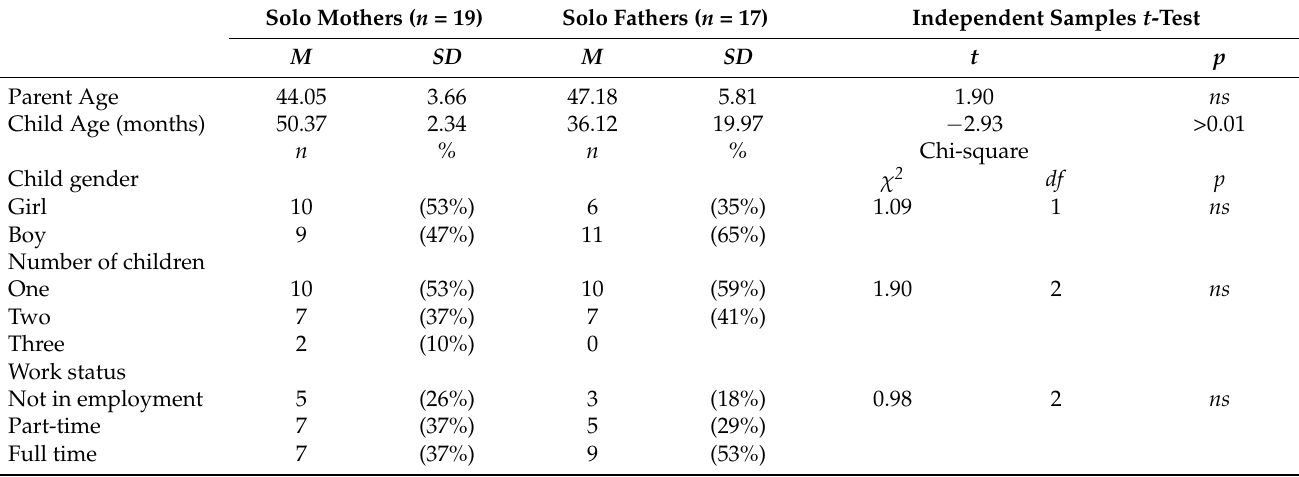
Table 1. Demographic